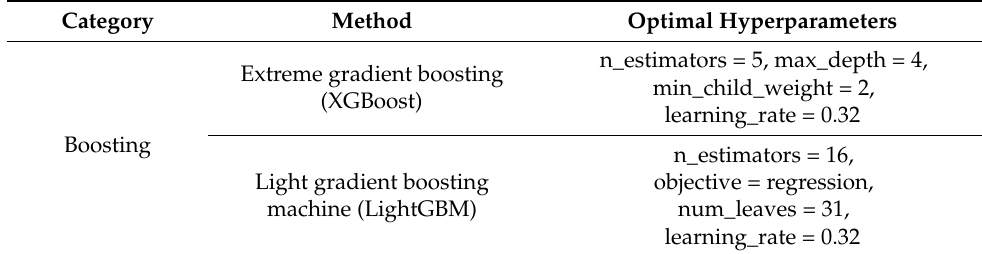
Table 3. Optimal hyperparameters of six machine learning